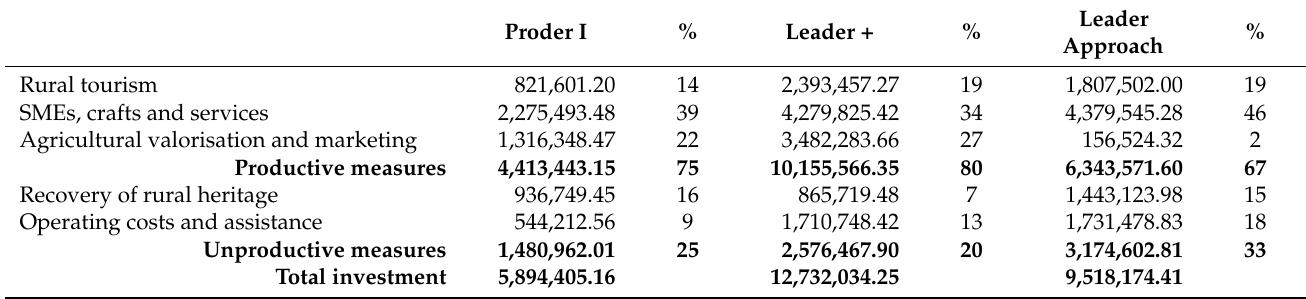
Table 5. Investment by measures in the Tajo-Salor region.